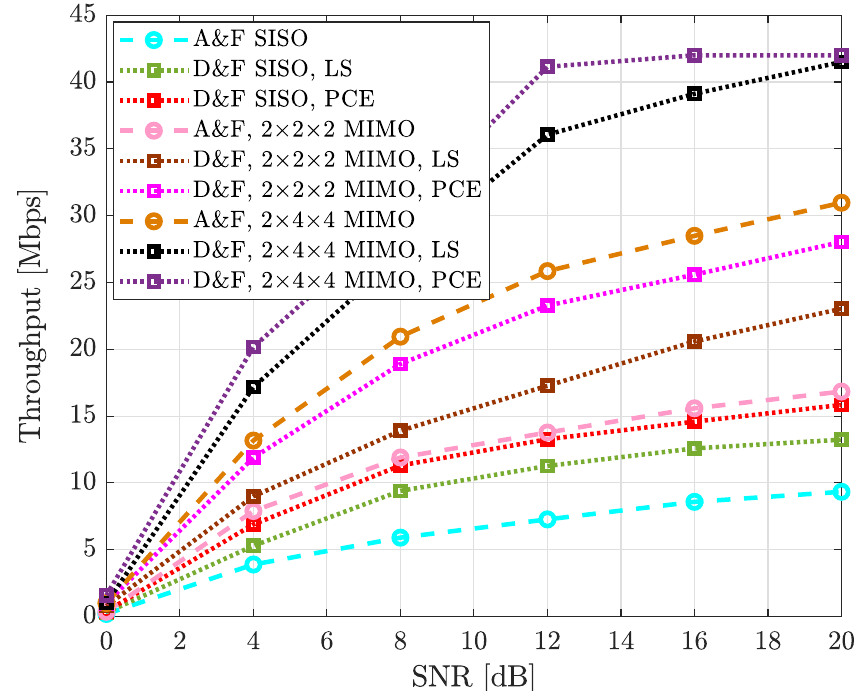
Figure 13. Throughput comparison for different uplink mmWave NR-RN co-operative schemes implemented with the 64-QAM